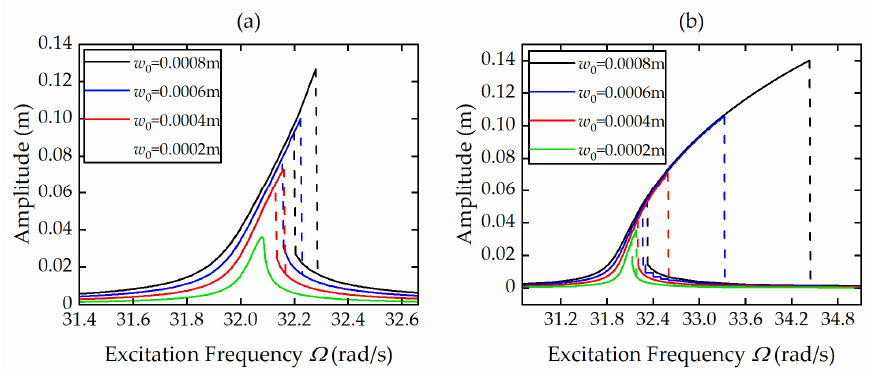
Figure 8. Frequency responses of the INDM ( a ) and the CNDM ( b ) with different excitation ampli-